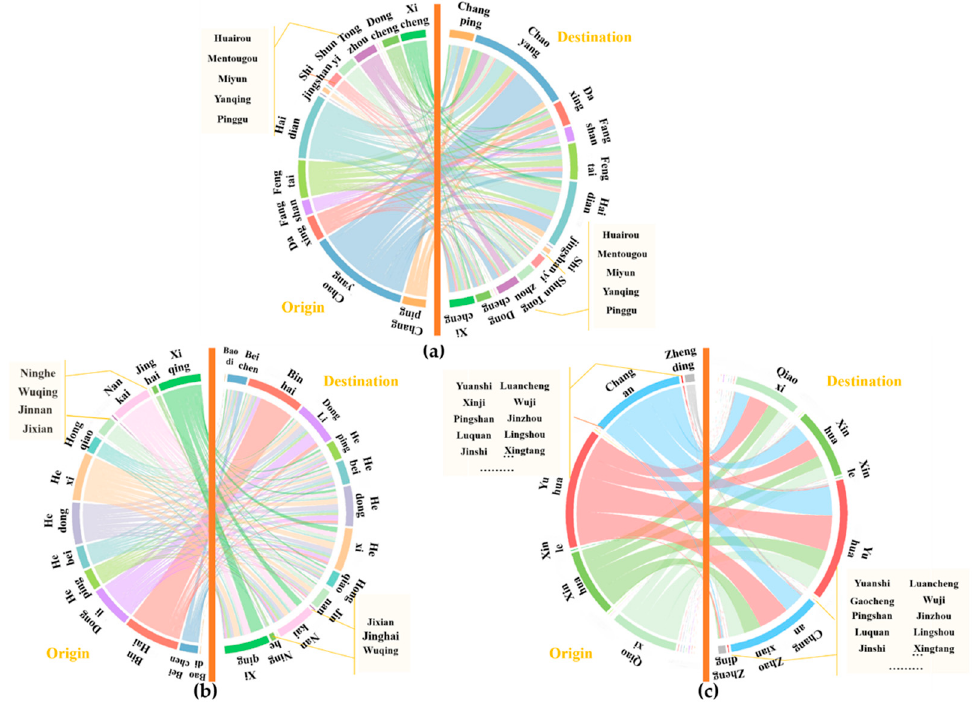
Figure 7. Distribution of ridesharing trip demand on an average day in BTH region. Multiple panels: ( a ) Beijing; ( b ) Tianjin; ( c ) Shijiazhuang.